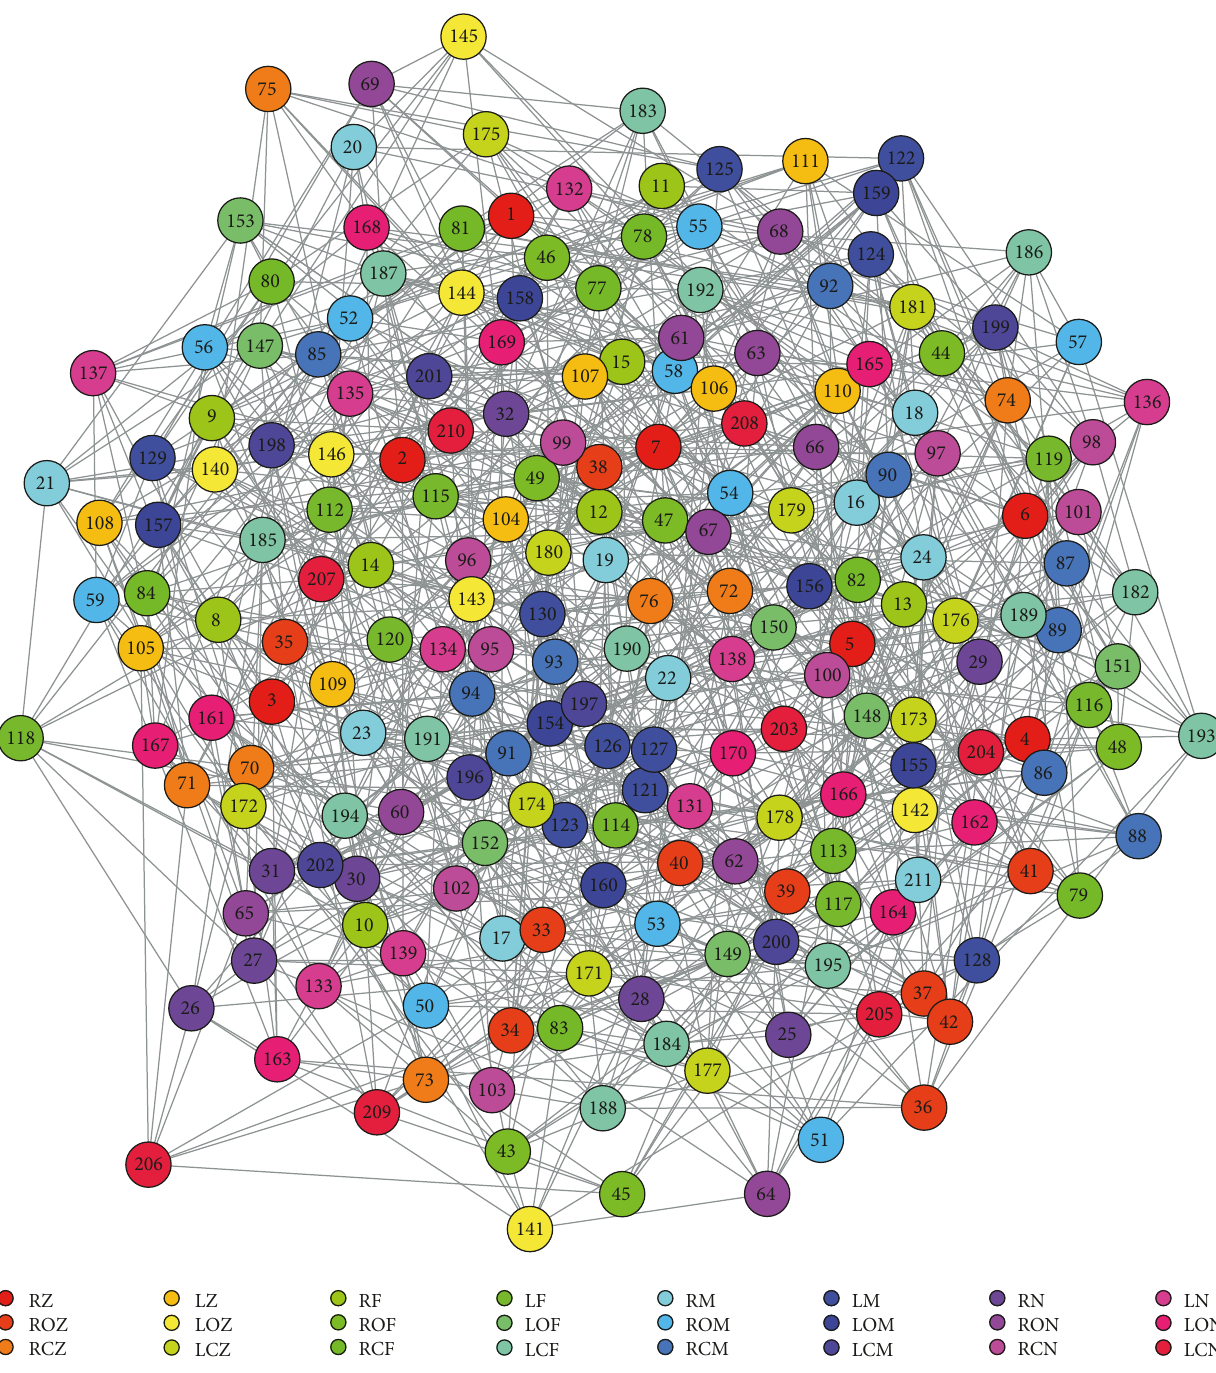
Figure 5: Decentralized